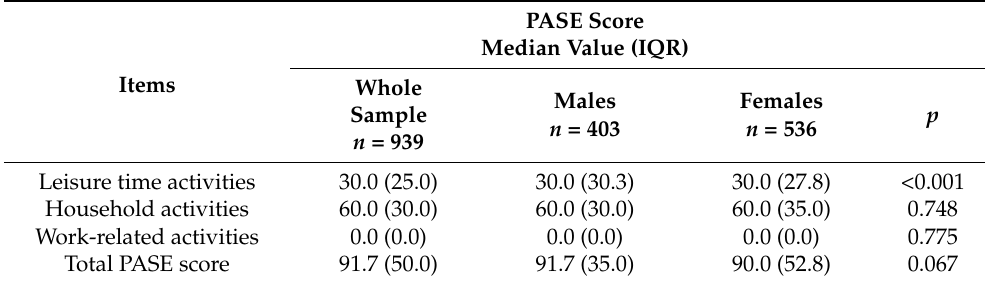
Table 3. Frequency of weekly activities reported by